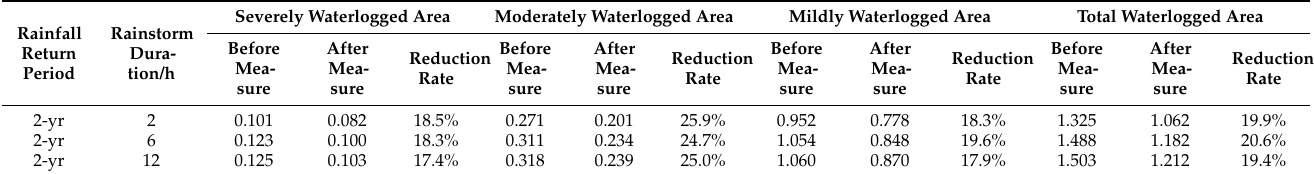
Table 13. Statistical analysis on waterlogged area reduction effect under different rainstorm duration (km 2 ).